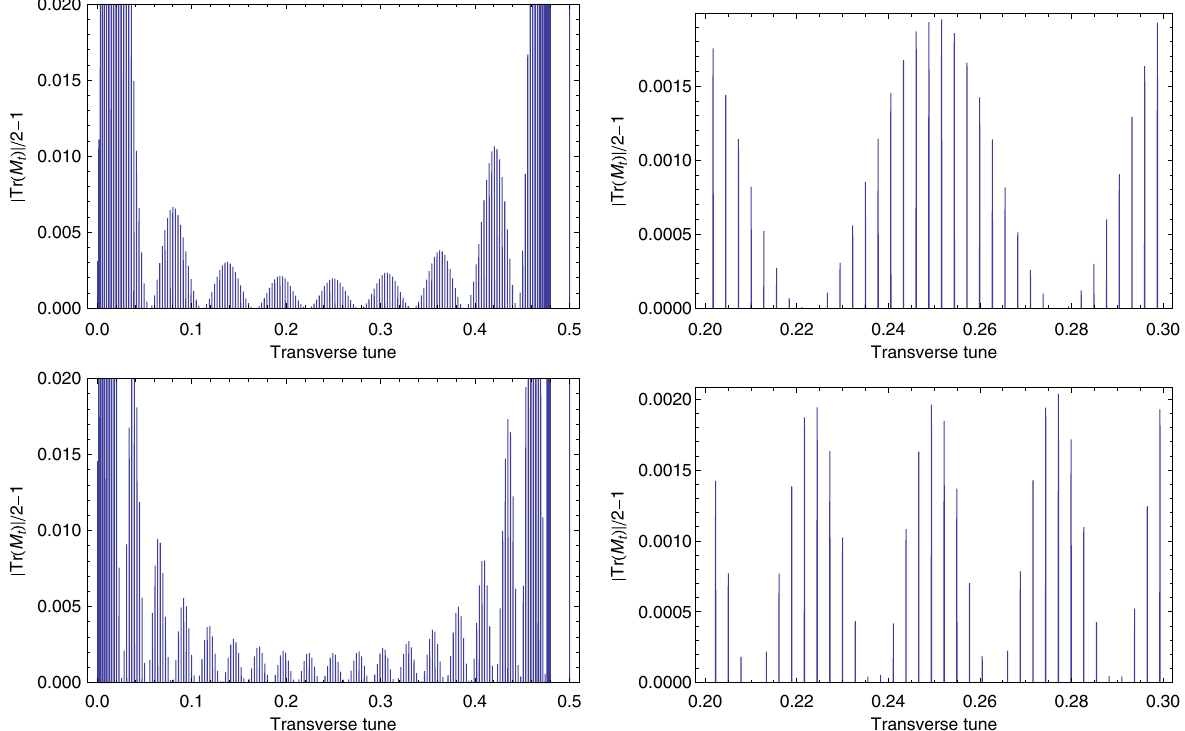
FIG. 7. j Tr ð M t Þj = 2 − 1 as function of betatron tune. The parameters used in calculation: beam-beam parameter is 0.01; N 2 ¼ 180 . In the top two figures, m ¼ 171 and n ¼ 9 ; in the bottom two figures, m ¼ 161 and n ¼ 19 . The right figures are the enlarged version of the left-hand